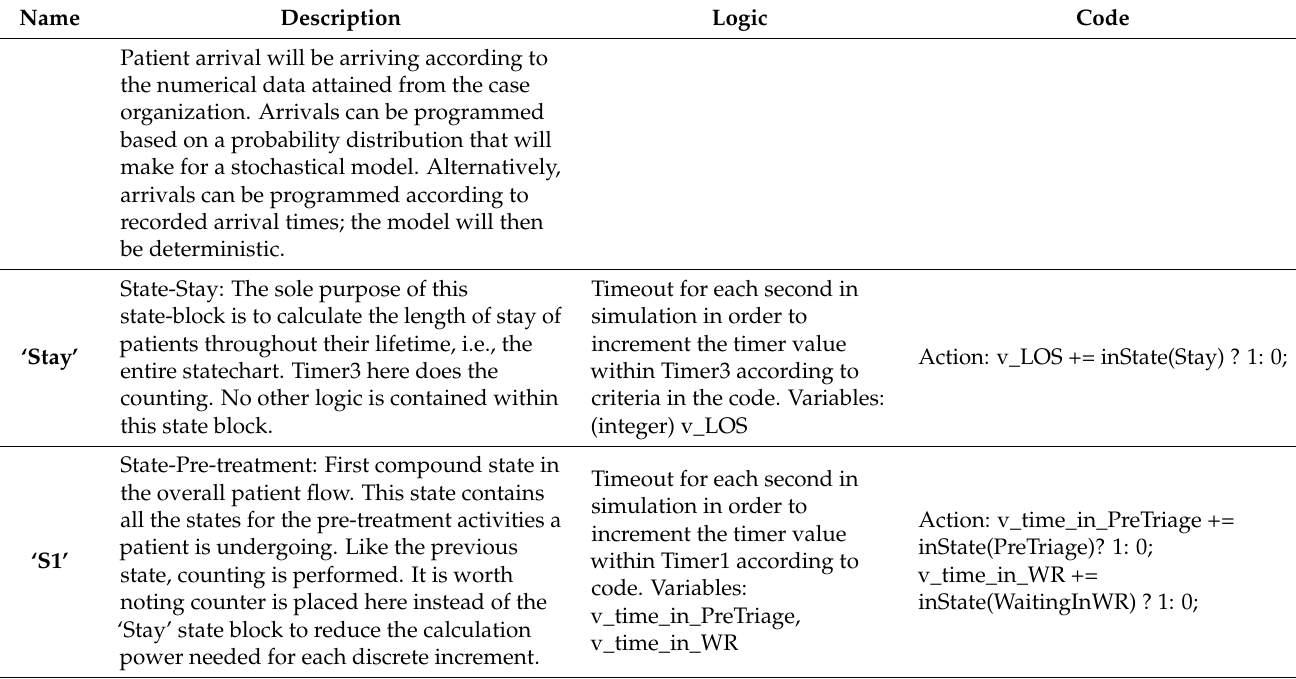
Figure 13. Effect on patient flow operation illustrated in sequence diagram pre- and peri-pandemic situation. Table 2. Description of the elements (states, transitions and initial conditions) of the patient agent statechart.